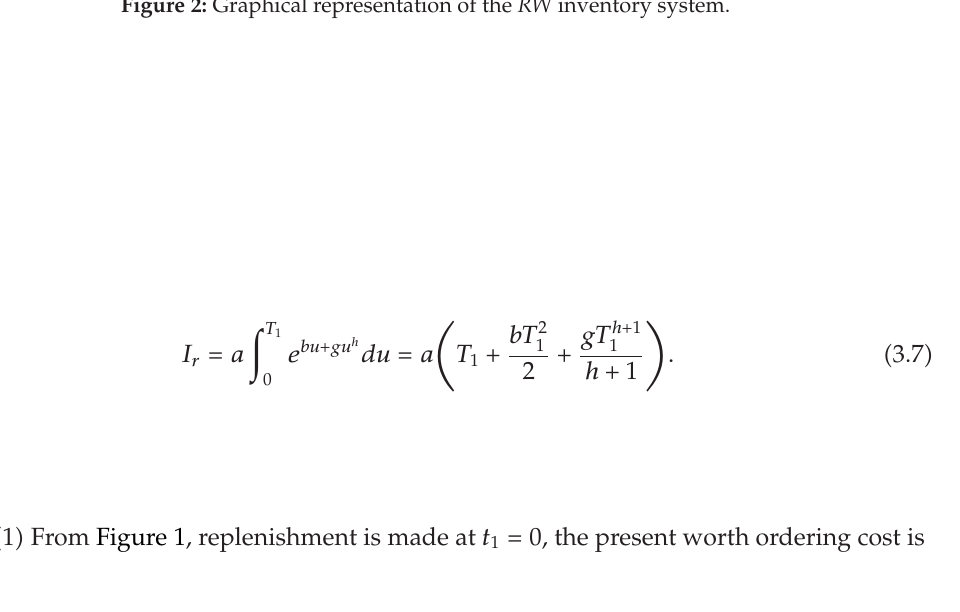
Figure 2: Graphical representation of the RW inventory